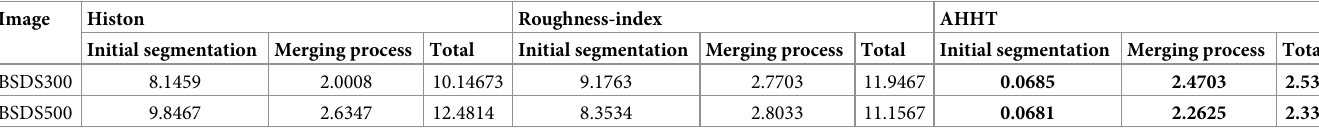
Table 6. Mean execution time (in seconds) of different algorithms. Image